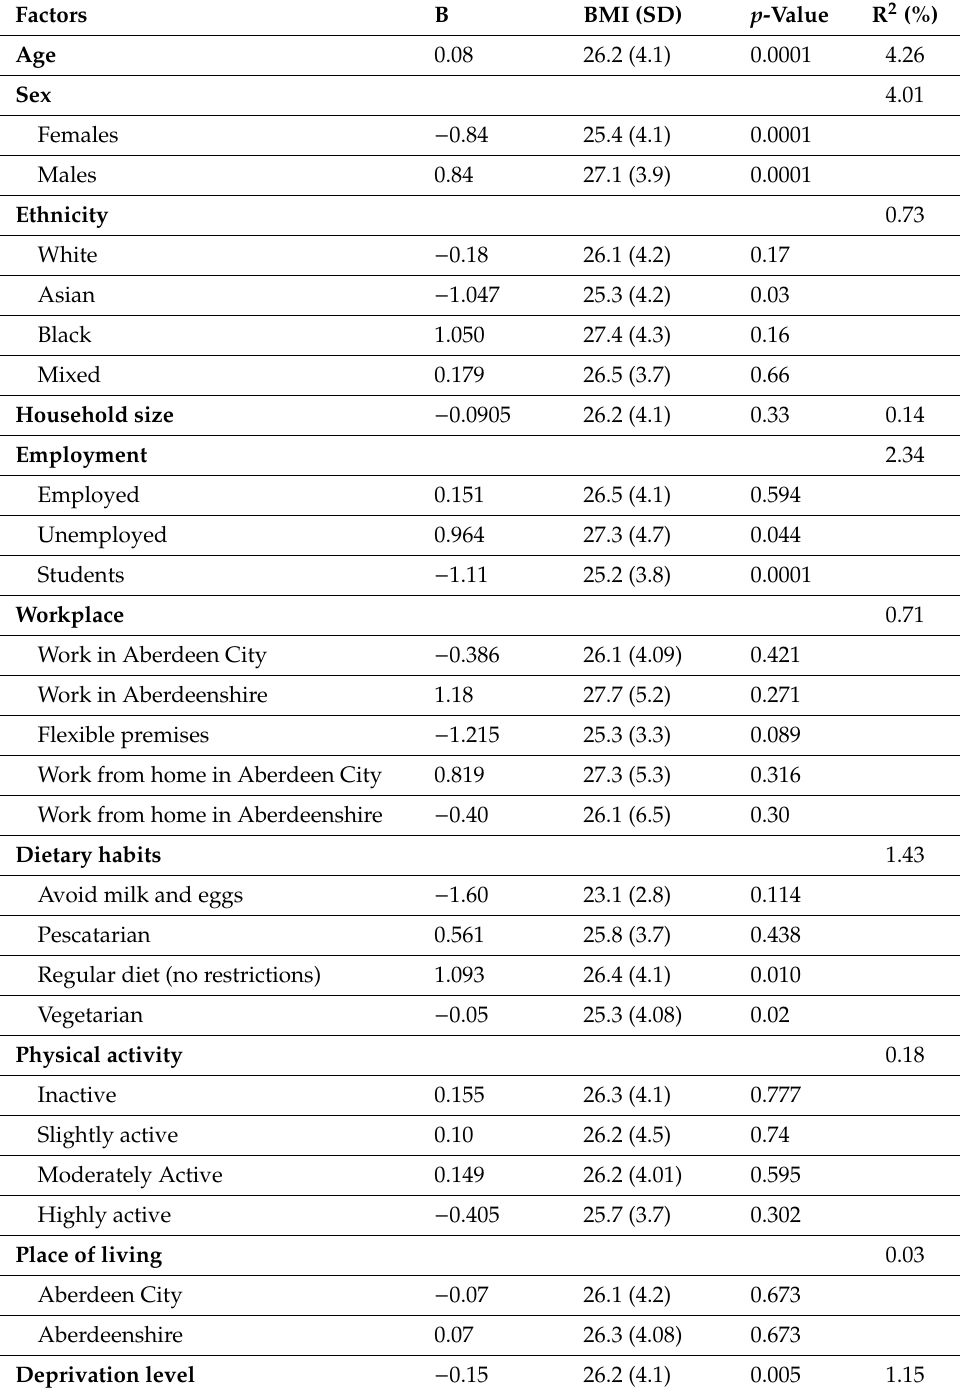
Table 2. General linear model analysis: BMI versus socioeconomic